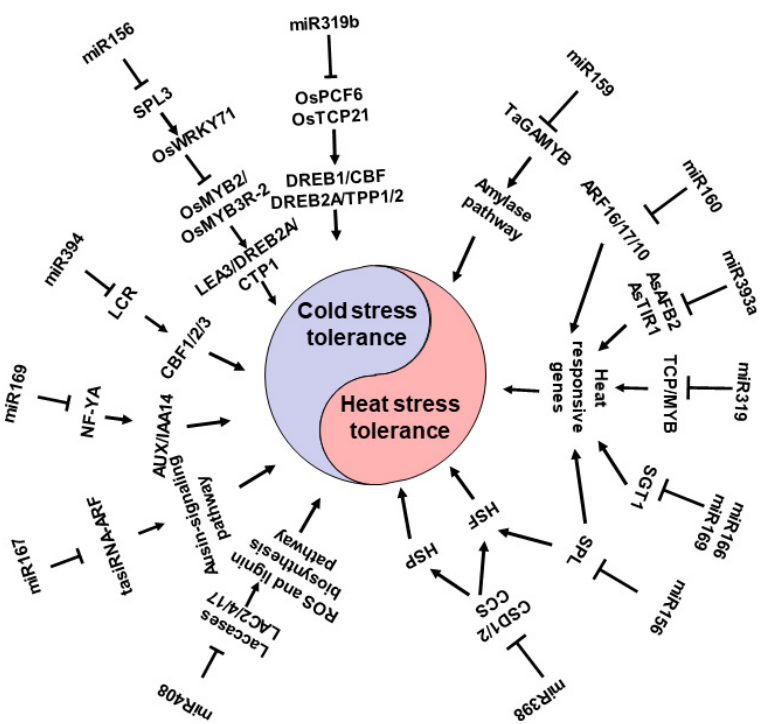
Figure 6. Pathway of miRNAs involved in abnormal temperature stress response in plants. MiR160, miR393, miR159, miR319, miR156, miR398, miR166/169 regulate heat stress responses in plants through the hormone/development/alternative splicing/ROS/HSPs and HSFs-related pathways. MiR319b, miR156, miR394, miR169, miR167, and miR408 also regulate cold stress responses in plants with their targets.